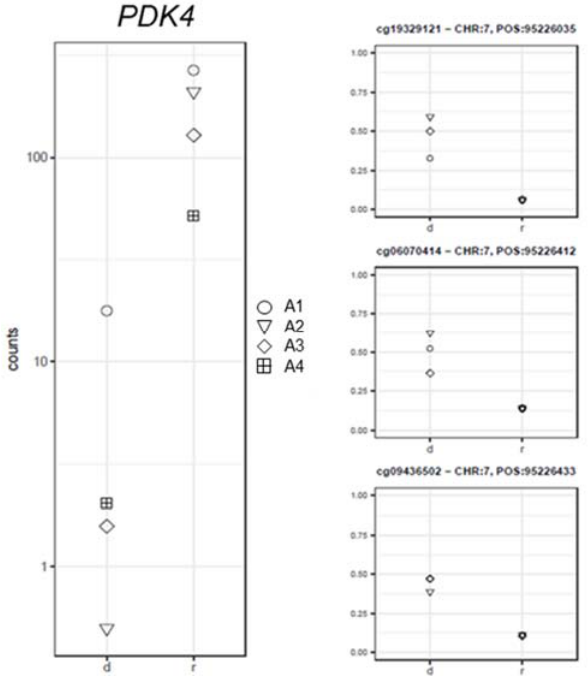
Figure 5. Gene expression (left panel) and corresponding methylation level (right panel) comparison between the samples at diagnosis (d) and remission (r) for the PDK4 gene. Moreover, the CXCL3 and RANBP17 gene expression values negatively correlated with the corresponding CpGs methylation levels ( CXCL3 : log2FC = − 6.09; PFDR = 1.03 × 10 − 7 ; − 0.95 ≤ rho ≤ − 0.85; Pcorr ≤ 0.04 (Figure 6) and RANBP17 : log2FC = − 6.01; PFDR = 5.38 × 10 − 8 ; − 0.93 ≤ rho ≤ − 0.91; Pcorr ≤ 0.02; Figure 7).